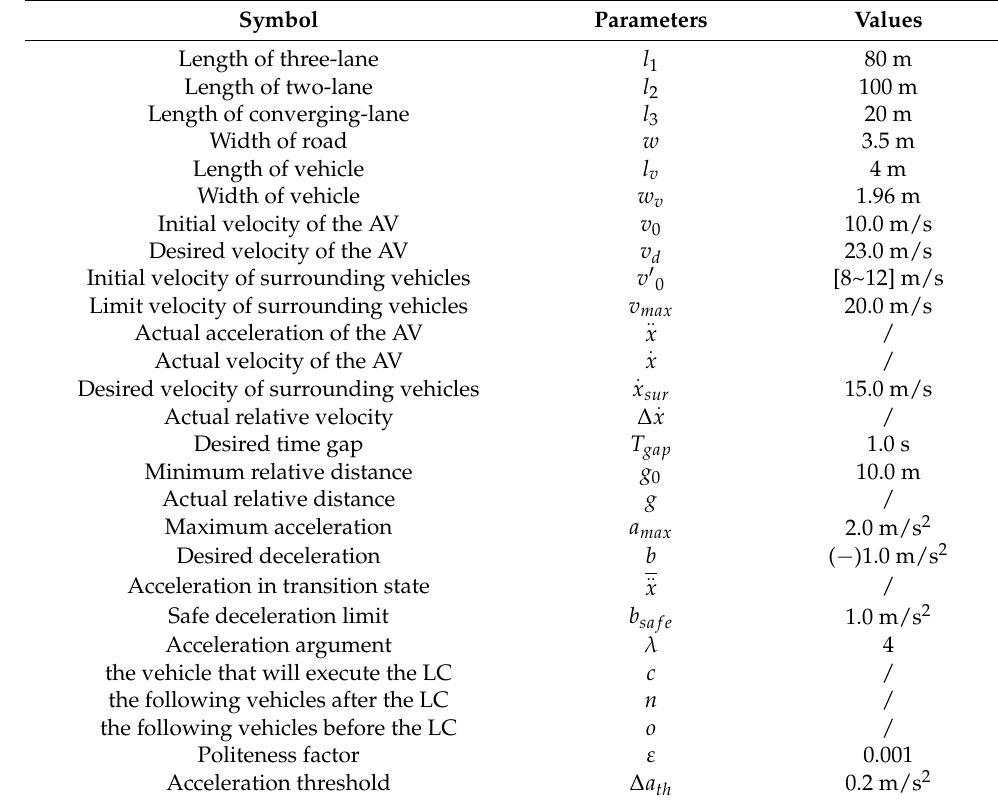
Table 3. Parameter setting of the scenario and the motion model of the surrounding vehicles. Symbol Parameters